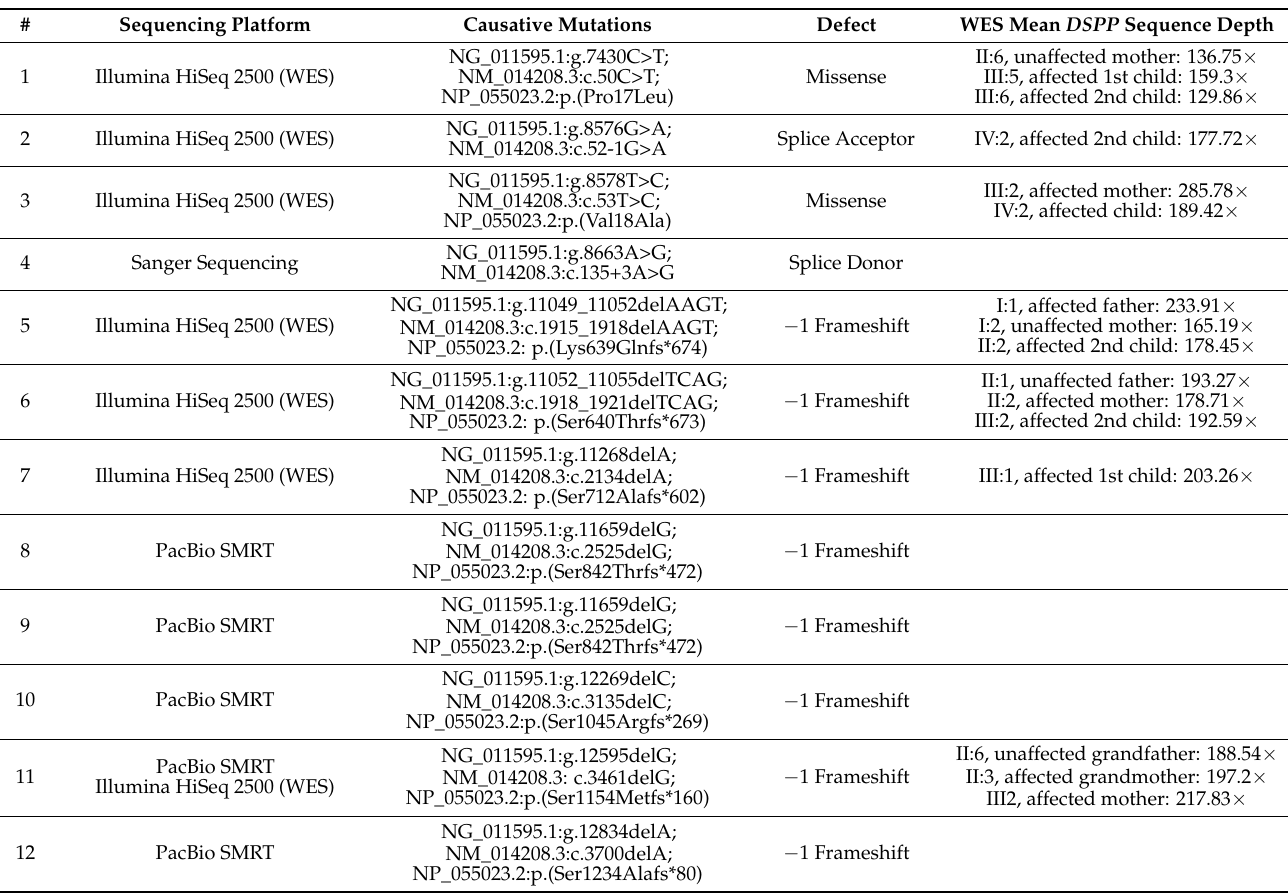
Table 3. Mutation Analysis that Defined the DSPP Disease-Causing Mutation in 12 Families with Autosomal Dominant Dentin